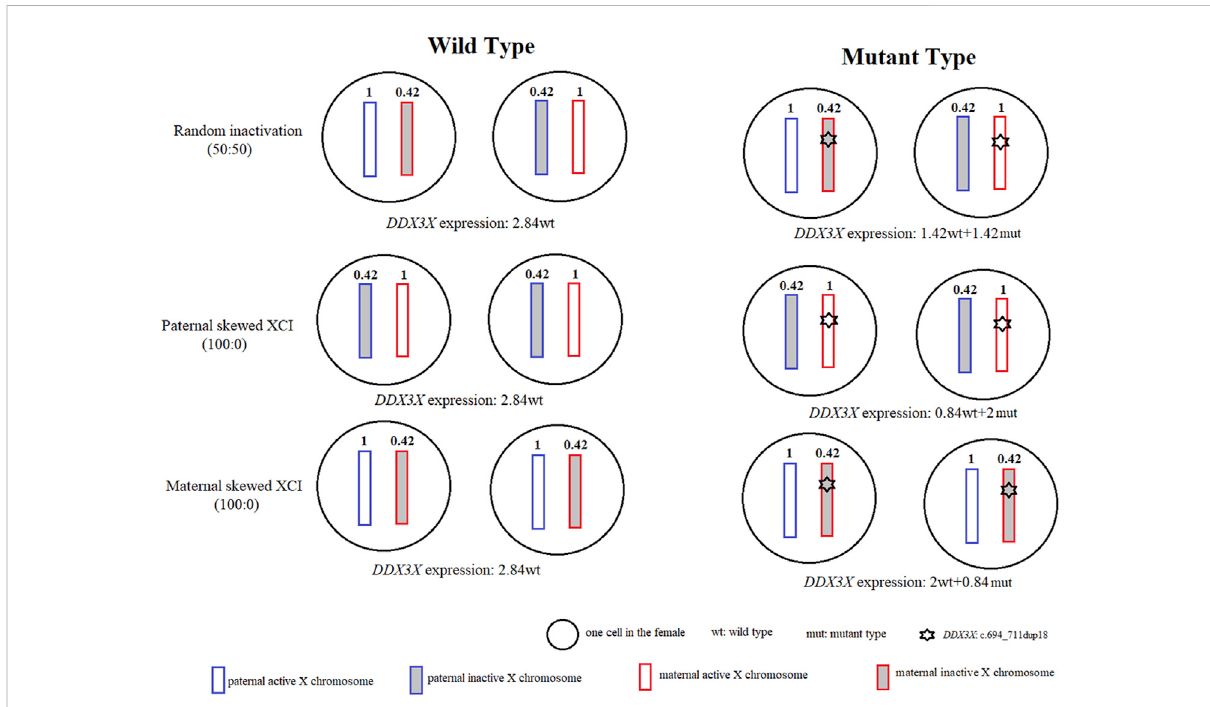
FIGURE 2 Modeled DDX3X expressionlevelsinnormalfemalesandfemaleswith DDX3X mutation.Fortwonormalfemalecells,therewerenodifferences for DDX3X expressions in random XCI, paternal and maternal skewed XCI, all were 2.84. For two female cells with DDX3X mutation. The wild type of DDX3X expressions respectively were 1.42, 0.84, 2 in random XCI, paternal and maternal skewed XCI, which were affected by the XCI pattern. The white and gray boxes represented the active X chromosome (Xa) and inactive X chromosome (Xi). The blue and red showed the paternal and maternal Xchromosome. The number inside the Xchromosome indicatedthe proportion of DDX3X expression according to ourdata.wt, wildtype; mut, mutation